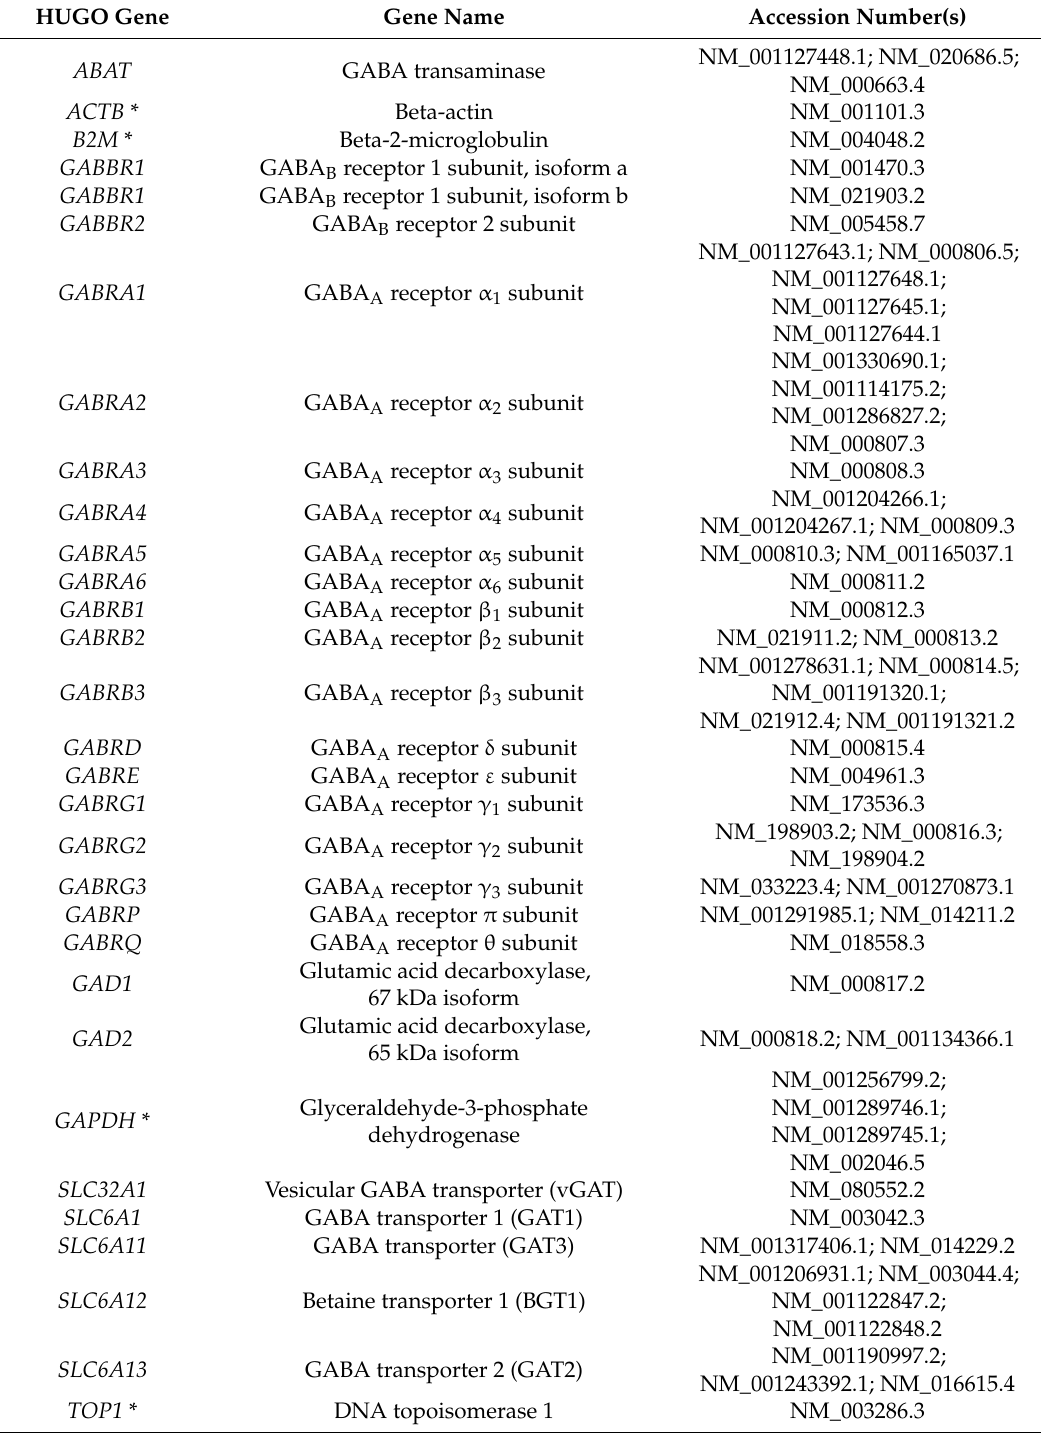
Table 5. Complete list of genes, isoform accession numbers and target sequences for NanoString nCounter